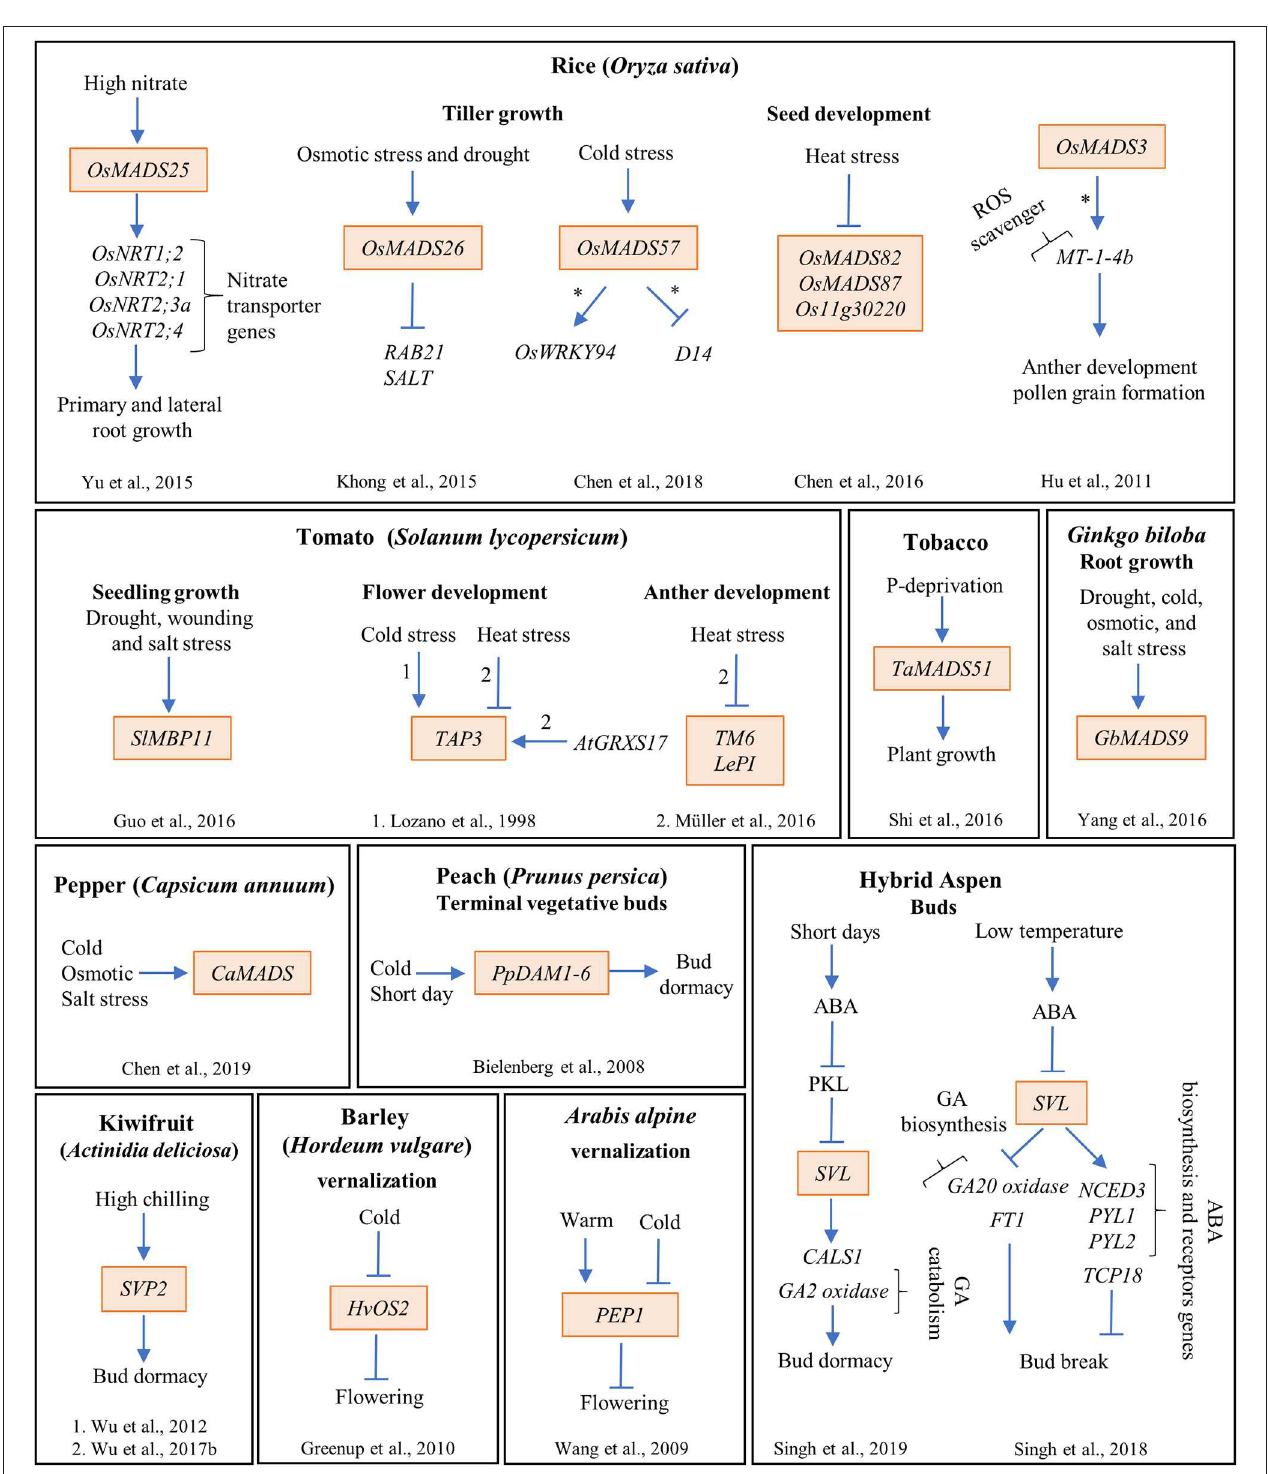
FIGURE 3 | The MADS-box genes participate in diverse genetic interactions that integrate the environmental signals to several development processes in different plant species. The MADS-box genes are highlighted in orange boxes; arrows and bar lines indicate induction and repression, respectively; asterisk (*) means direct regulation; and the numbers on the arrows indicate the reference where the data were obtained.